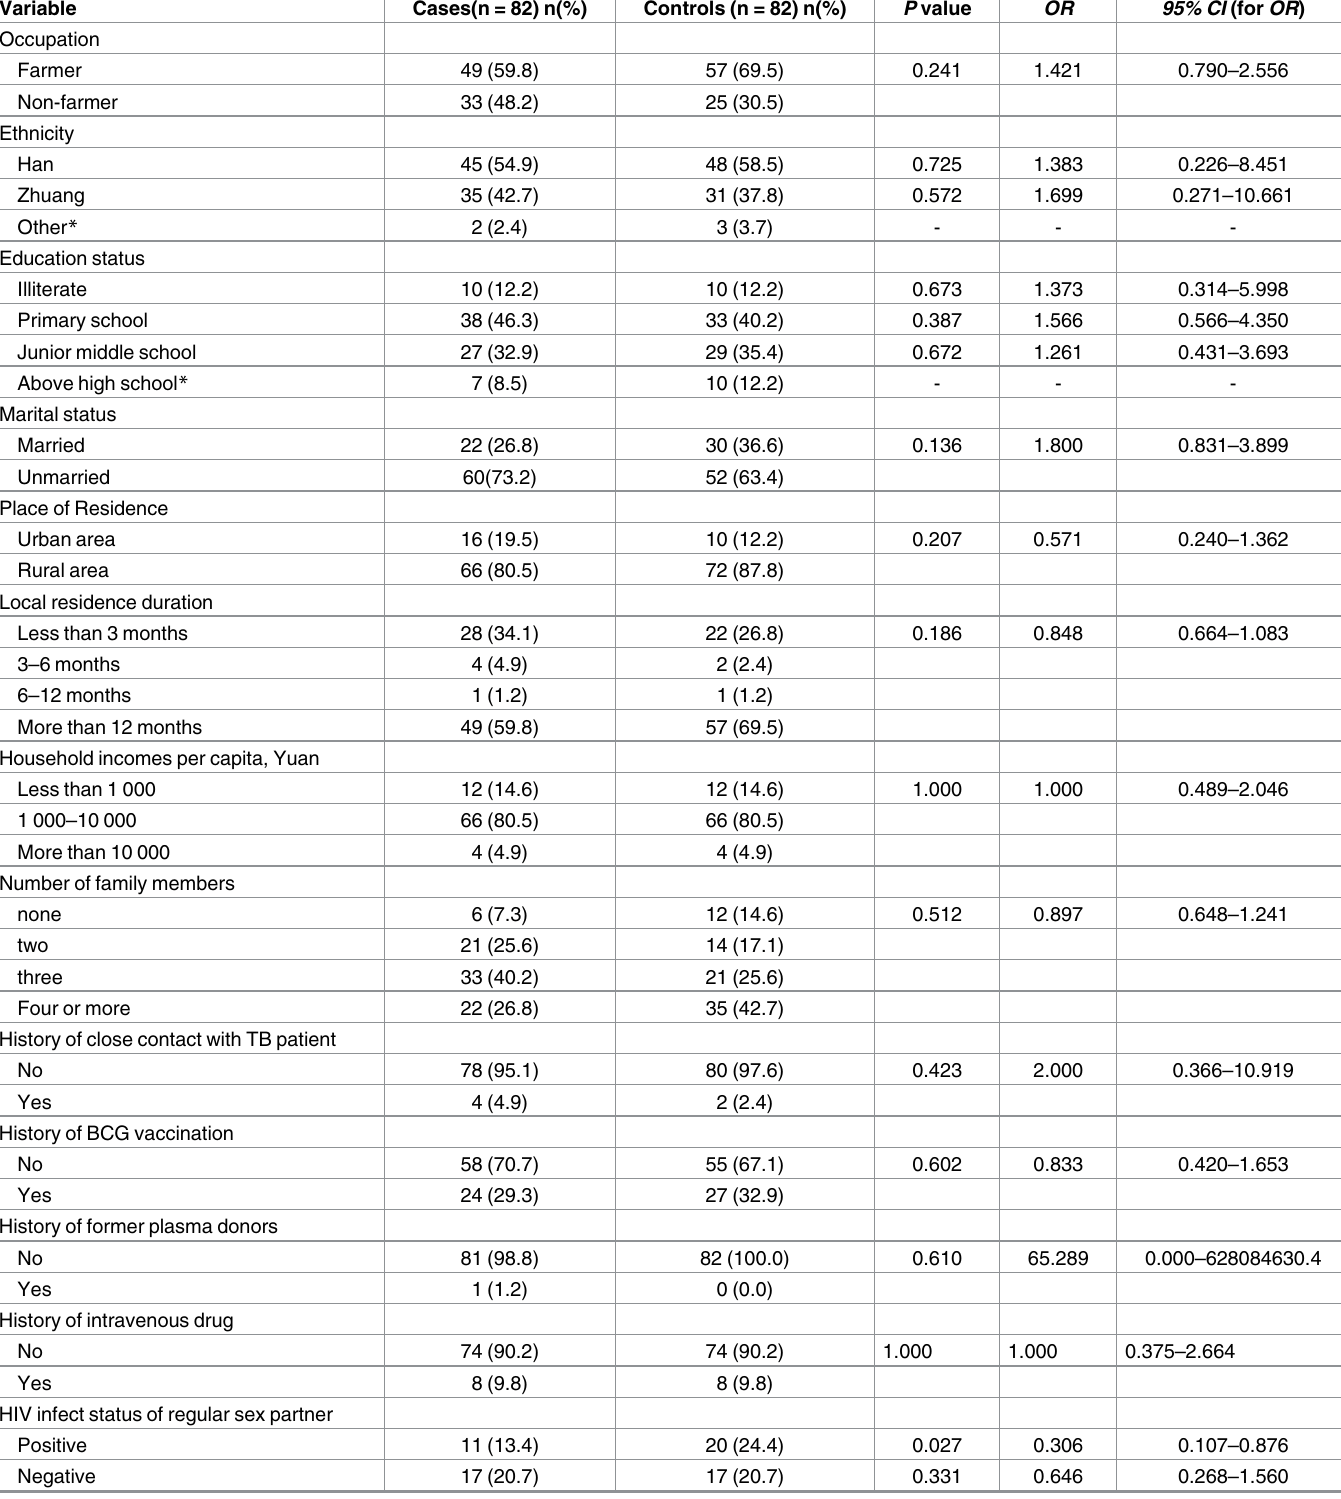
Table 3. Characteristics of cases and